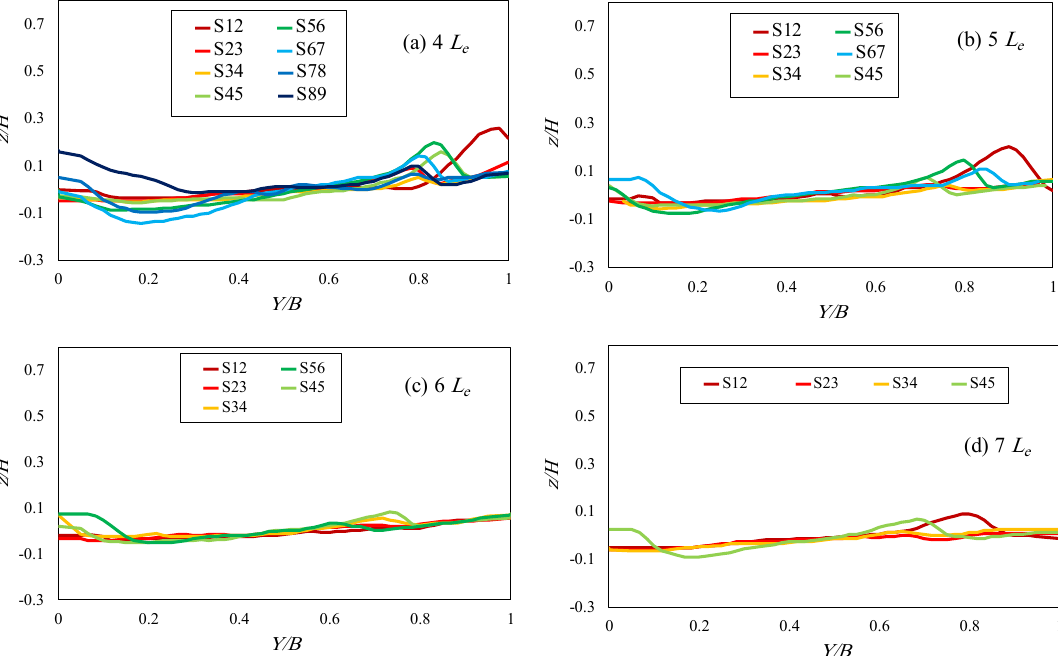
Figure 12. Cross sections between two consecutive structures at particle Froude number of 2.37. ( a ) 4 L e , ( b ) 5 L e , ( c ) 6 L e , and ( d ) 7 L e .